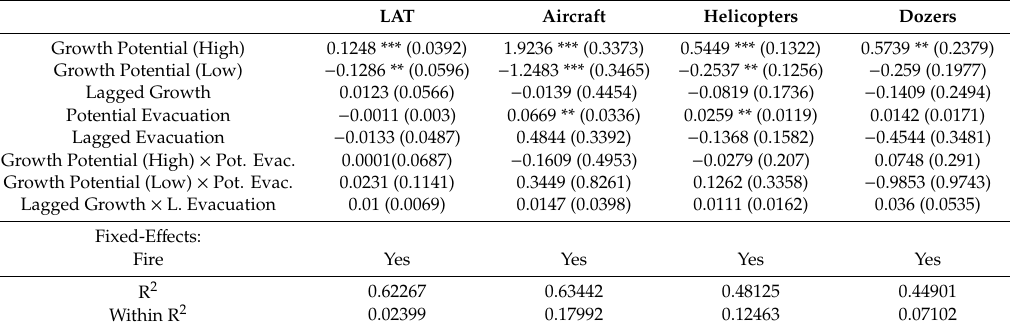
Table 6. Linear fixed e ff ect regression of select suppression